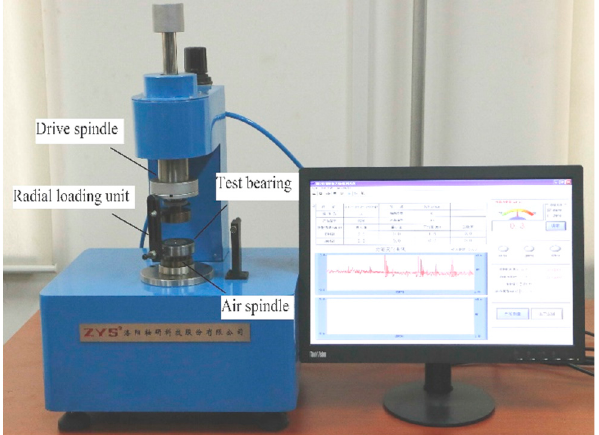
Figure 9. M9908B bearing friction torque measuring instrument.